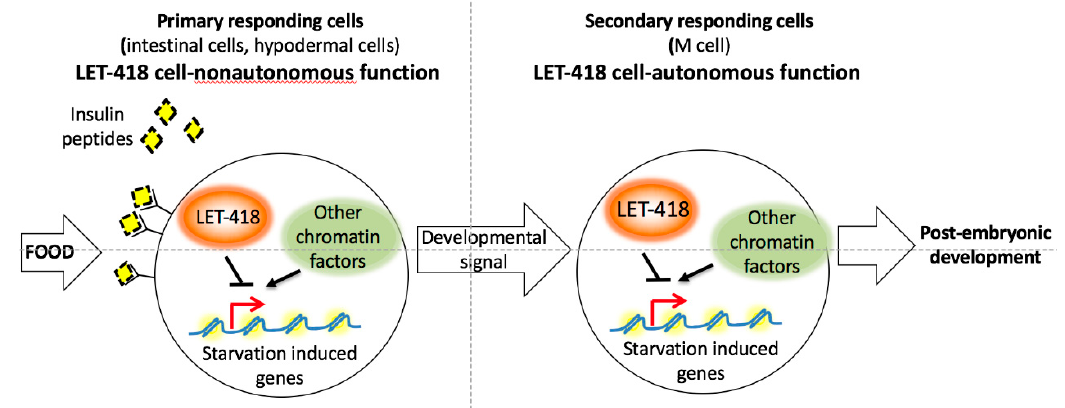
Figure 8. Model of LET-418 function in the transition to post-embryonic development (for more details see text).